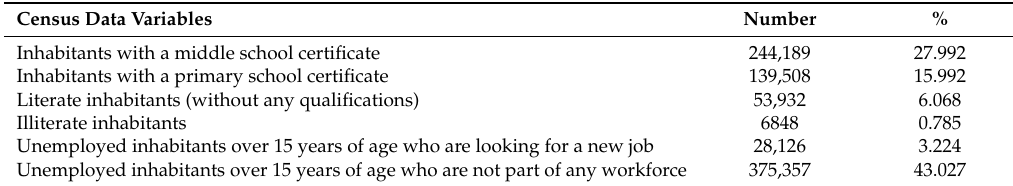
Table 1. Turin population sample: descriptive statistics of the census data variables (Source: Authors’ elaboration on 2011 ISTAT 15th Population and housing